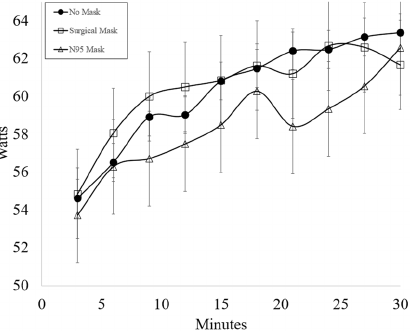
Figure 1. Average power output (mean ± SD) for each testing condition ( n = 19).